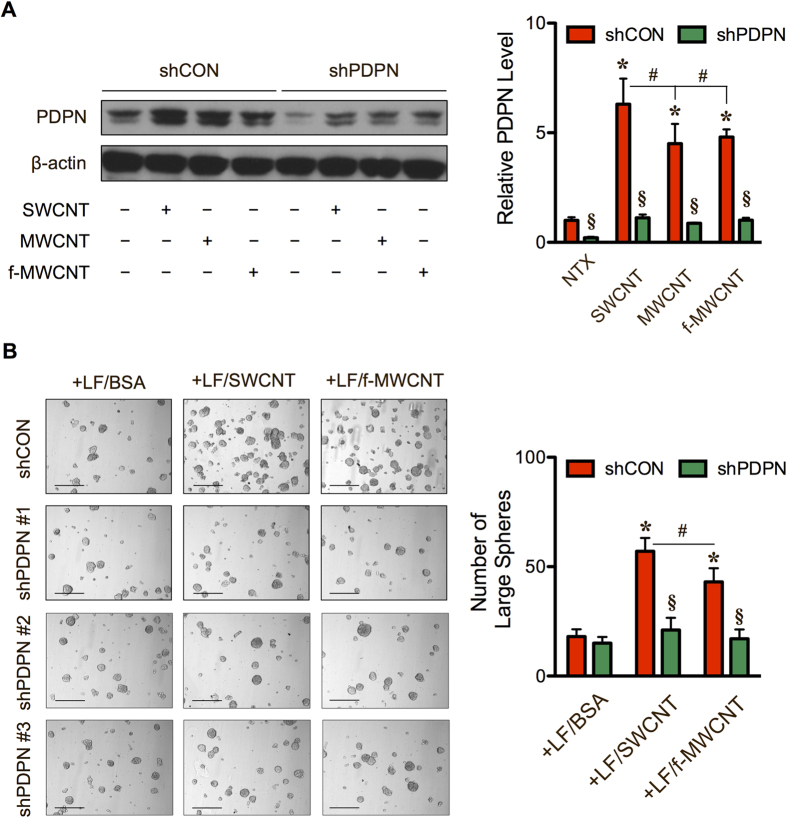
Carbon nanotube-induced cancer associated fibroblast-like cells are incapable of inducing cancer stem cells in the absence of podoplanin.(A) Human lung fibroblasts were stably transfected with shRNA plasmid against podoplanin (shPDPN) or scramble control (shCON), and treated with SWCNT, MWCNT or f-MWCNT at the dose of 0.15 μg/cm2 for 48 h. Podoplanin level was detected by Western blotting. (B) Carbon nanotube-induced cancer-associated shCON fibroblast-like cells (shCON-LF/SWCNT or LF/f-MWCNT) or carbon nanotube-treated shPDPN fibroblast-like cells (shPDPN-LF/SWNCT or LF/f-MWCNT) were co-cultured with H460 cells (2:1 ratio), and tumor sphere formation was analyzed after 2 weeks of culture. Scale bar = 200 μm. Data are mean ± SD (n = 4). *P < 0.05 vs H460 and shCON-LF/BSA group. §P < 0.05 vs CNT-treated shCON group. #P < 0.05 vs shCON-LF/SWCNT group.